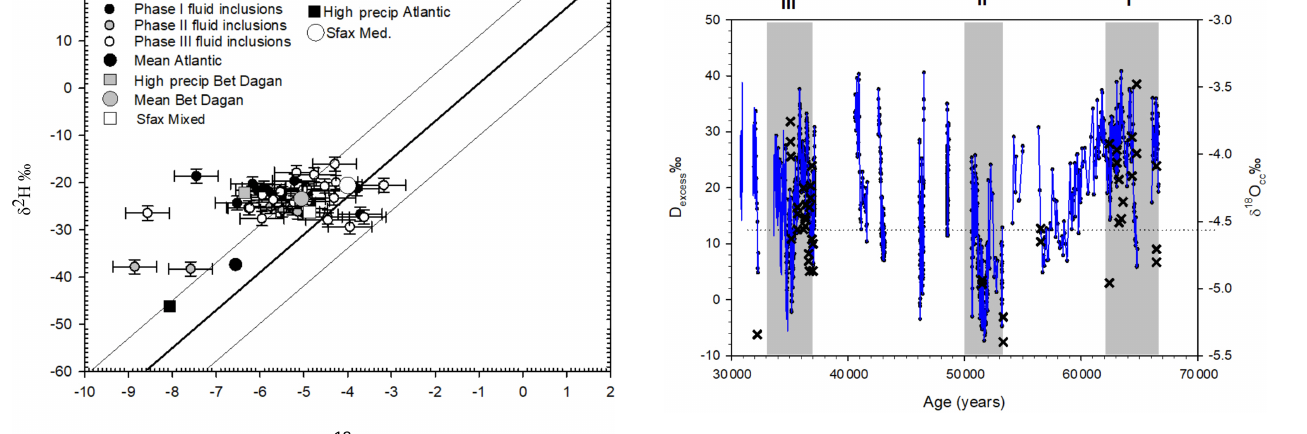
Figure 10. Fluid inclusion deuterium excess ( δ 2 H excess − FI ) rela- tive to calcite δ 18 O cc . Note some fluid inclusions (70 to 60kyrBP and 40 to 30kyrBP) show high ( δ 2 H excess − Fi ) indicative of an east- ern Mediterranean source. Growth Phases I, II and III are shown as grey